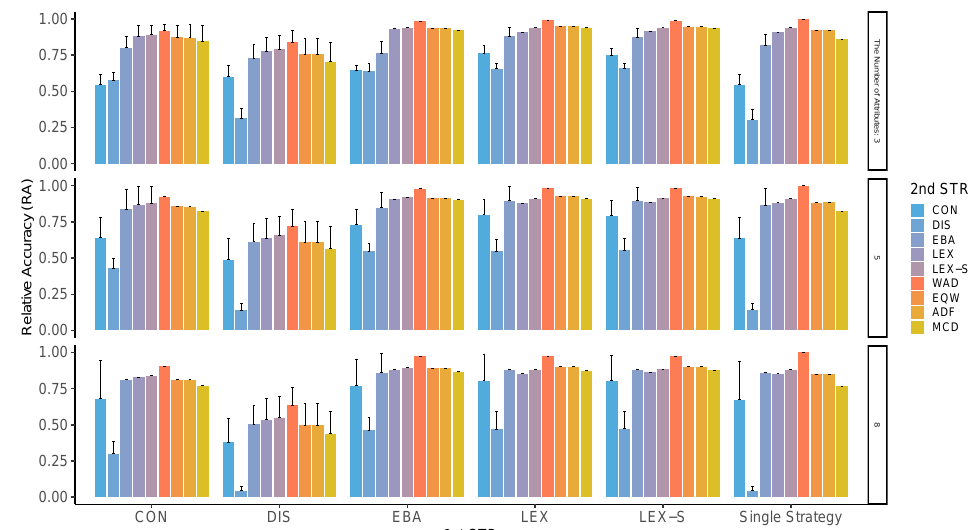
Figure A4. RA in two-stage decision-making when three alternatives are left in the second stage for the different numbers of attributes. Note: ADF: additive difference; CON: conjunctive; DIS: disjunctive; EBA: elimination by aspects; EQW: equal-weighted strategy; LEX: lexicographic; LEX-S: lexicographic semi-order; MCD: majority of confirming dimensions; STR: strategy; WAD: weighted additive.